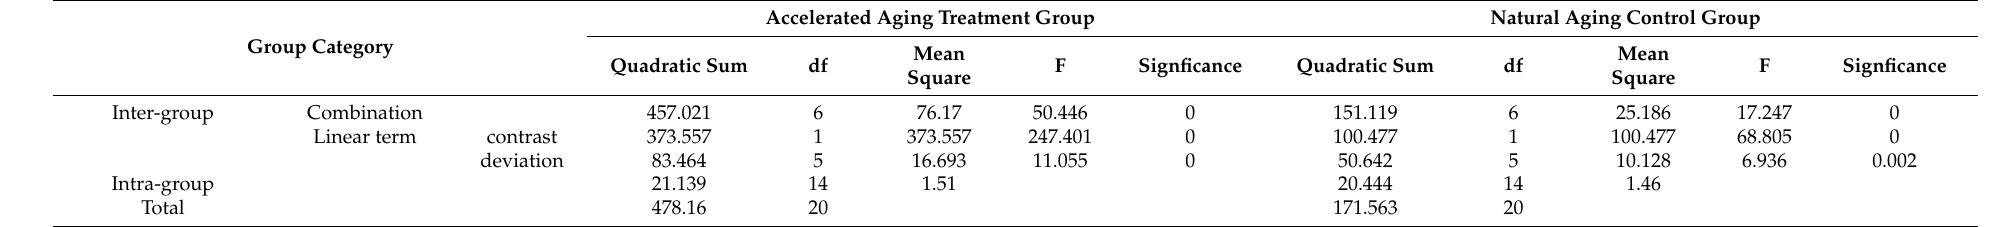
Table 3. Values of cellulose crystallinity during aging of bamboo ANOVA.